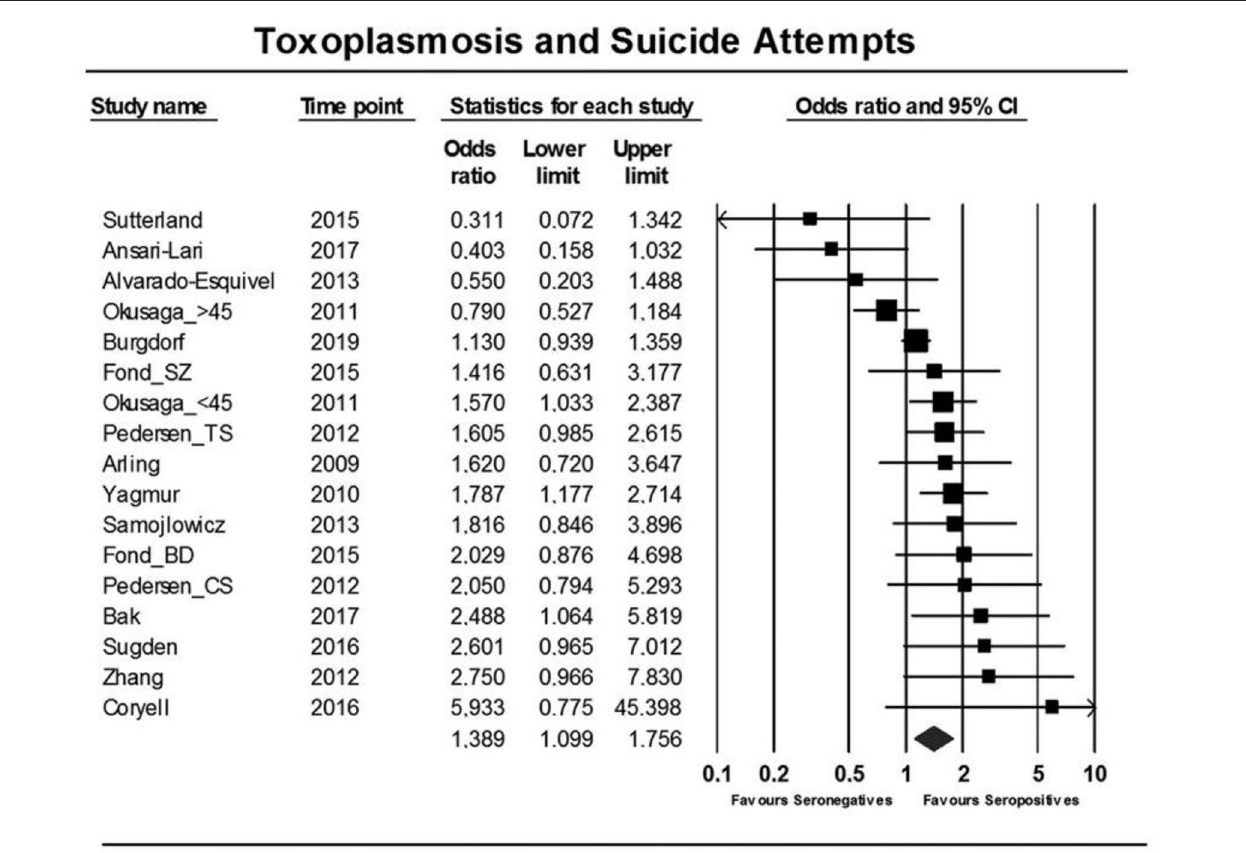
FIGURE 2 | Forest plot showing an association between T. gondii infection and suicide attempts as reported in a meta-analysis by Sutterland et al. (80) using the random effects model. Serointensity has not been presented, and, thus, the first study on T. gondii infection and suicide attempt appears as negative [Modified and reprinted with permission from (80); Copyright (2019); with permission from Cambridge University Press; License #